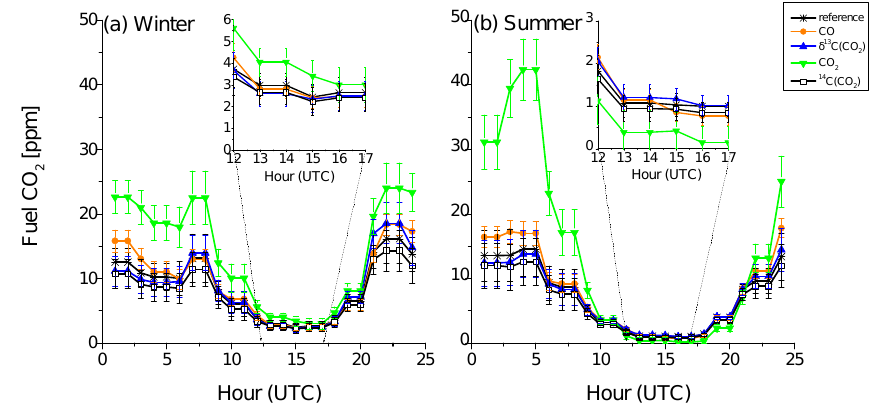
Figure 8. Comparison of median diurnal cycle of fuel CO 2 given in model reference or estimated with one of six different tracer methods at the measurement station Heidelberg. Error bars denote the standard error of the fuel CO 2 estimate at each hour for the respective half year. The diurnal cycle of the CO + δ 13 C(CO 2 ) methods are not shown since they are very similar to the δ 13 C(CO 2 ) method.